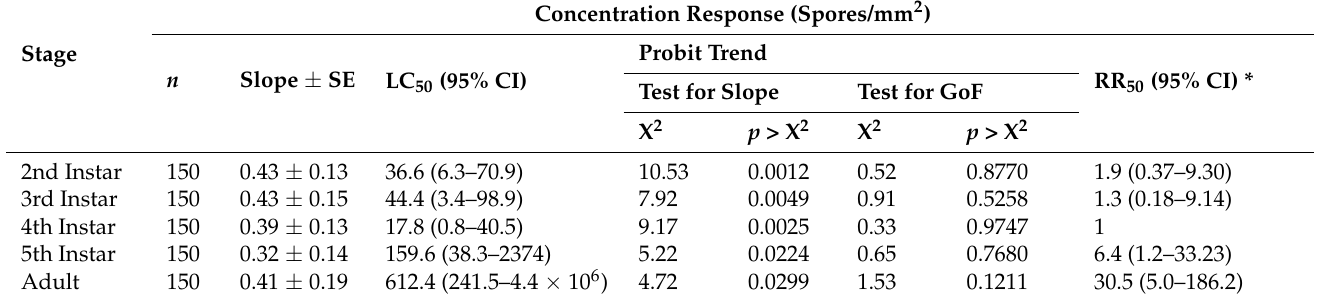
Table 2. Lethal mortality-response (LC 50 ) of different stages of Nezara viridula treated by contact (treated diet) with Beauveria bassiana , Mississippi Delta native strain